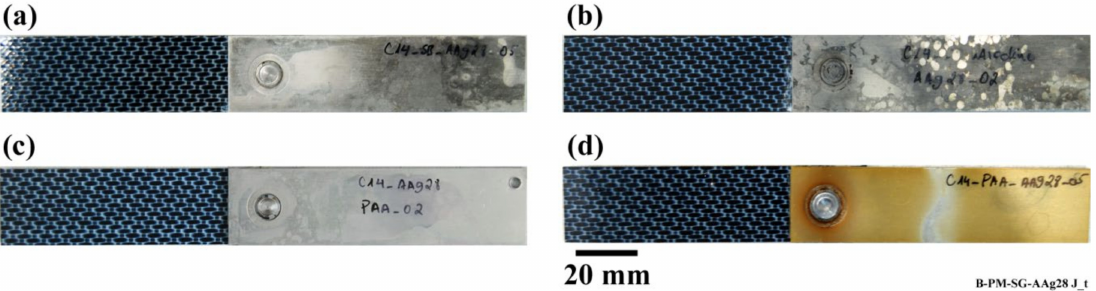
Figure 1. Top view of the SLS FSp joints after 28 days of aging; ( a ) SB, ( b ) CC, ( c ) PAA, and ( d )